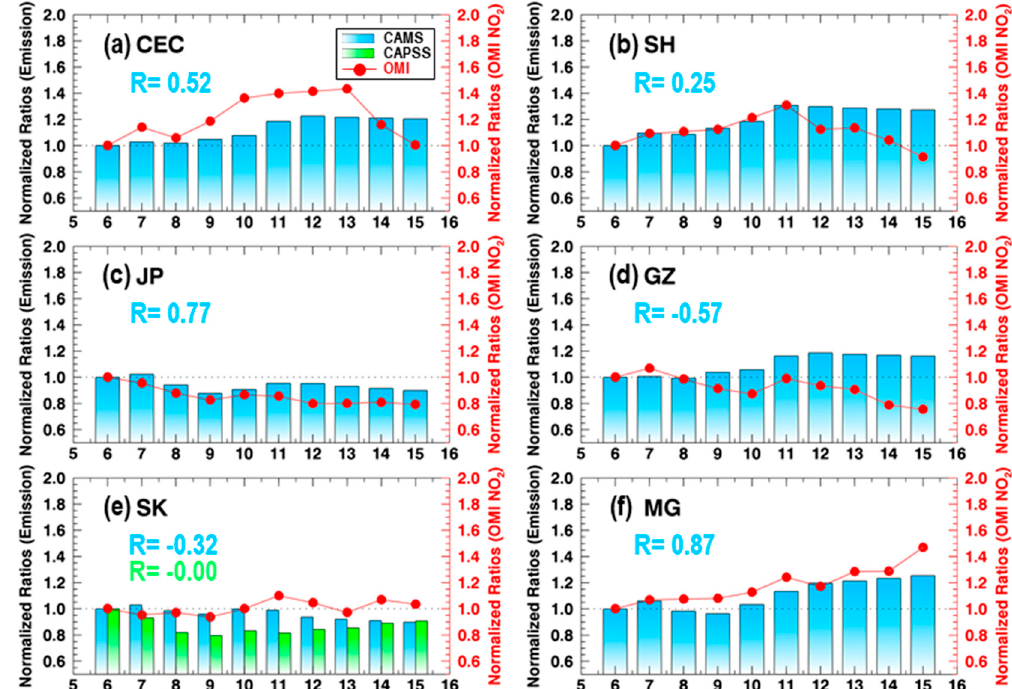
Figure 7. Year-to-year variations of NO x emissions (blue and green bars for CAMS and CAPSS, respectively) and NO 2 columns (red circles) normalized to those in 2006 for ( a ) CEC, ( b ) SH, ( c ) JP, ( d ) GZ, ( e ) SK, and ( f ) MG.